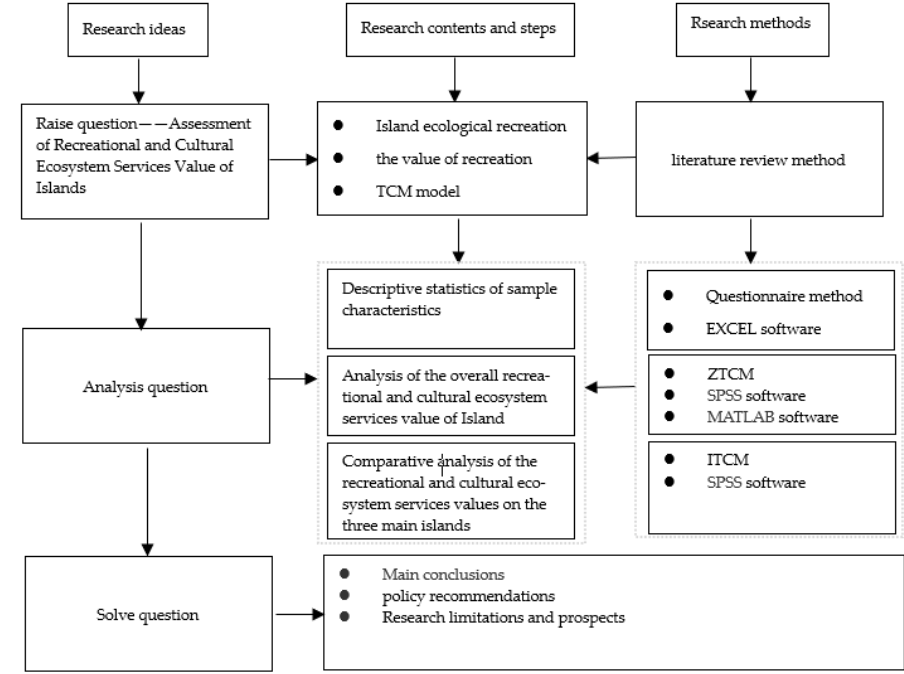
Figure 2. Methods and technical